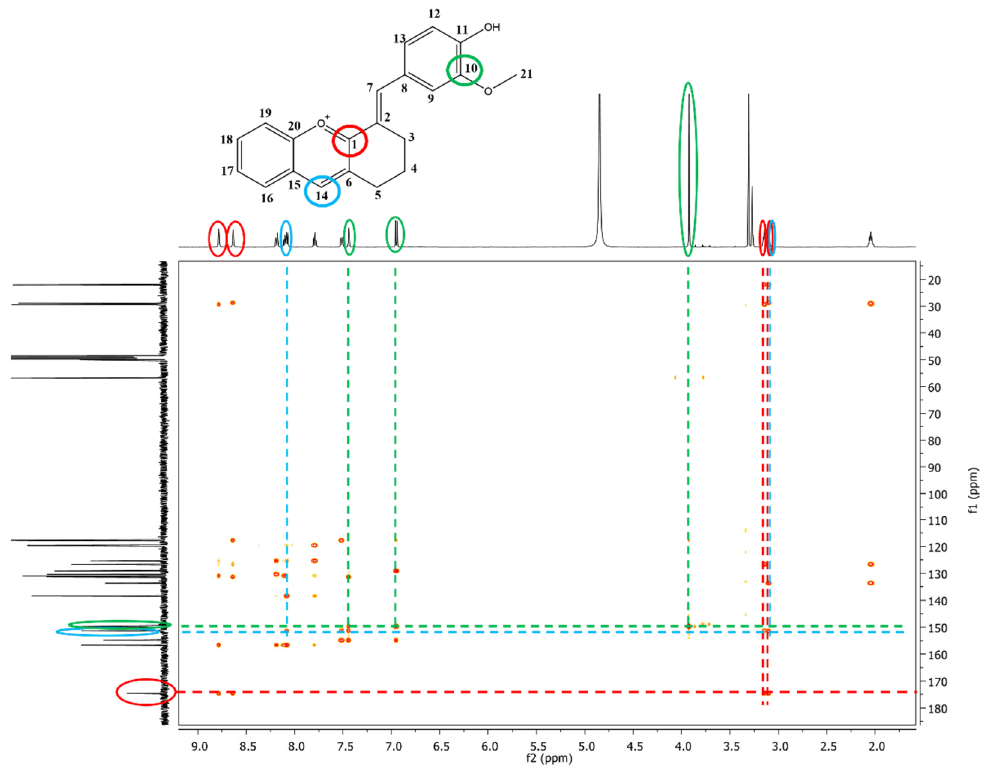
Figure 2. The 1 H- 13 C-HMBC spectrum of compound 3 —the remote couplings between carbon atoms and protons are depicted by different colored circles, green—C10 with H9, H12, and H13, red—C1 with H3, H5, H7, and H14, blue—C14 with H5, and H16.